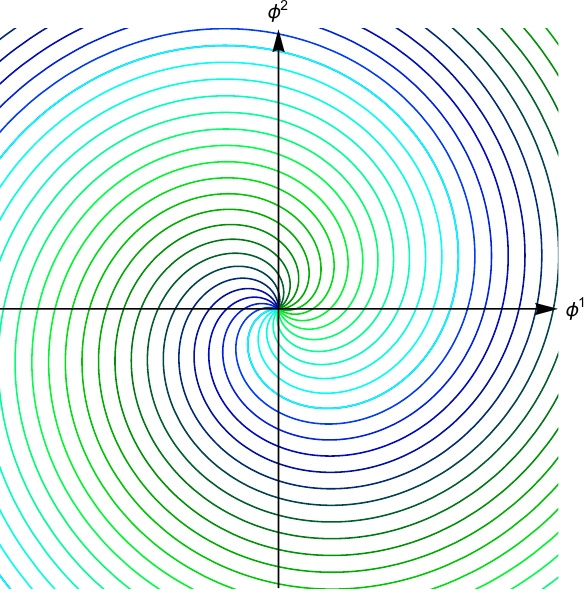
Figure 8 . Archimedean spirals (B.3) with di(cid:11)ererent values of (cid:2) 0 for (cid:11) given by (B.10). The corresponding velocity (cid:12)eld (B.4) has a non-zero curl